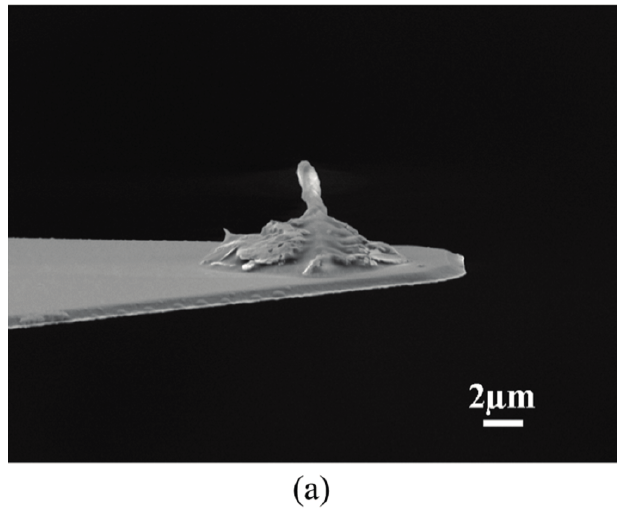
Figure 6. ( a ) SEM image of the micro-pillar attached on the tipless Atomic Force Microscopy (AFM) probe; ( b ) Measured adhesion curves of single fabricated micro-pillar and